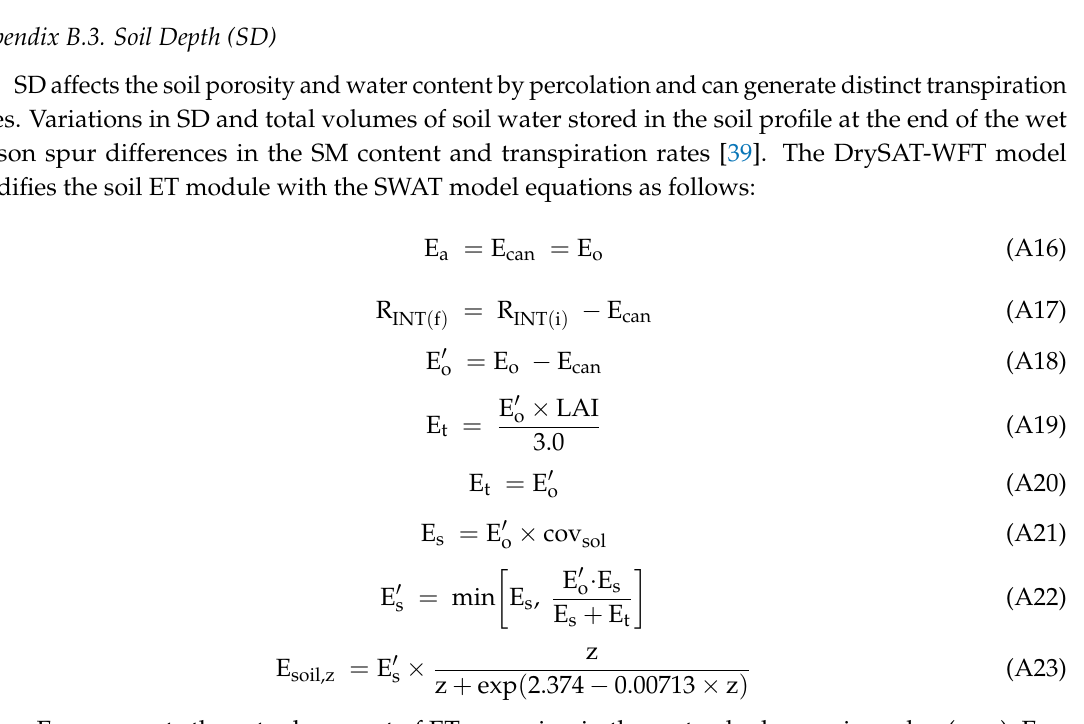
Figure A2. Distribution map of forest heights (FHs) from 1976 to 2015 in the study